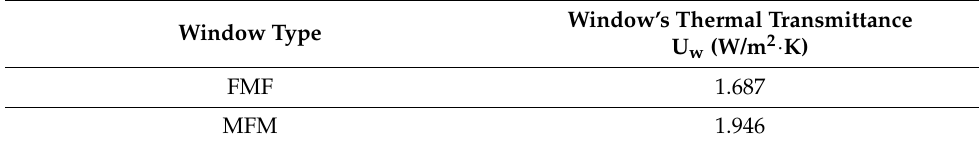
Table 5. Thermal transmittance of the windows (U w